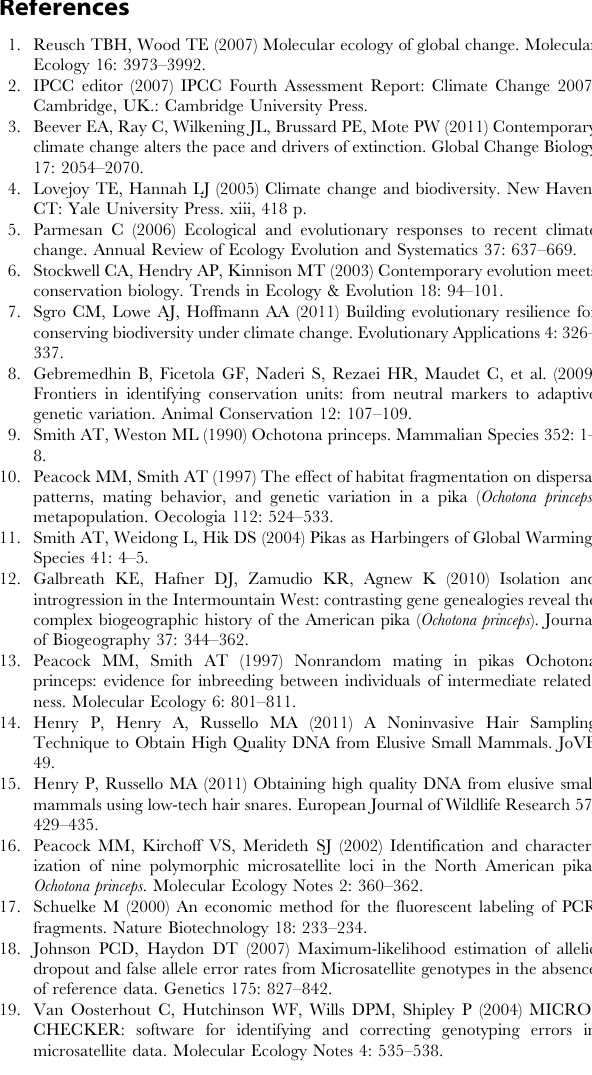
Table S6 Mean estimates of the distribution of recent migration rates ( m ) calculated using B AYESASS + [ 28 ] , given as the proportion of migrant individuals per population per generations. Table S7 Results of the tests of demographic history for each